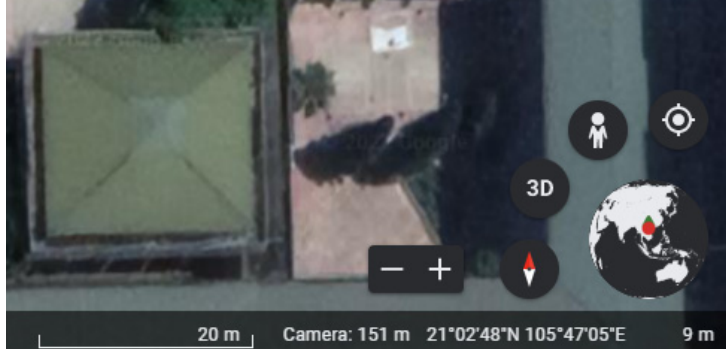
Figure 2. Installation position of the rooftop solar power system (Google